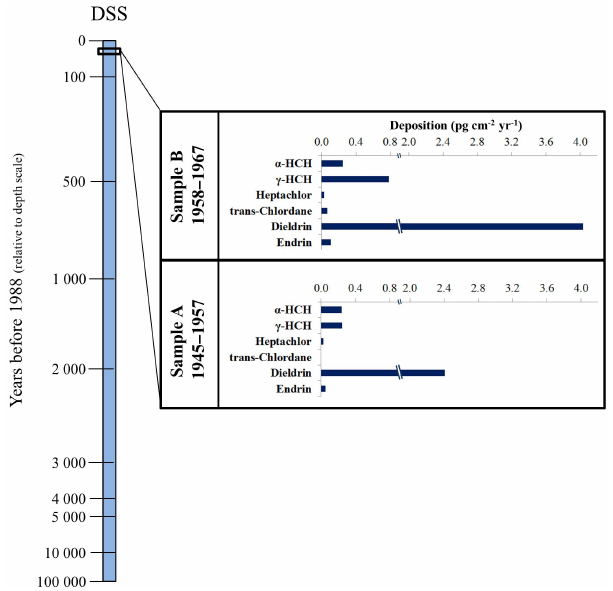
Figure 3. Deposition rates of six legacy OCPs at the Law Dome site in Antarctica between 1945 and 1957 (sample A) and 1958 and 1967 (sample B). Note: results should be considered as maximum possible